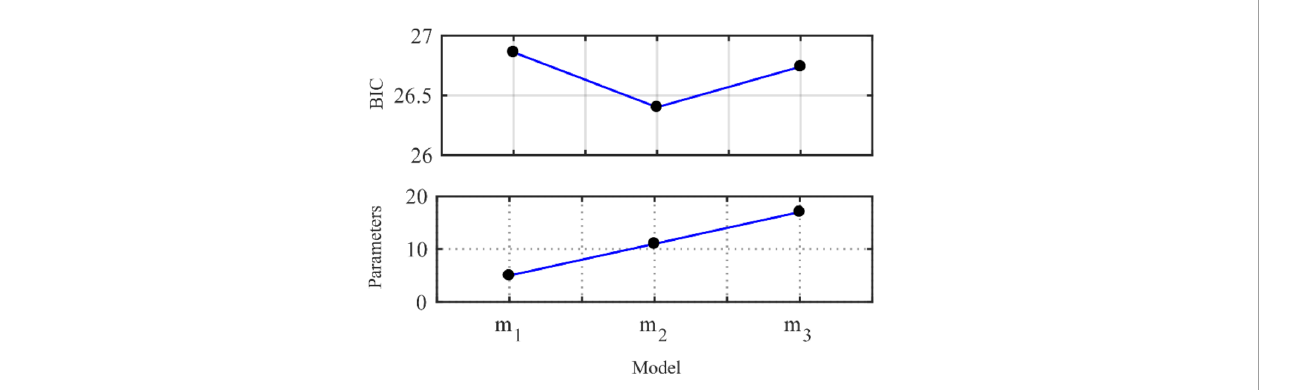
FIGURE 13 The result of model selection, the number of model parameters and the BIC